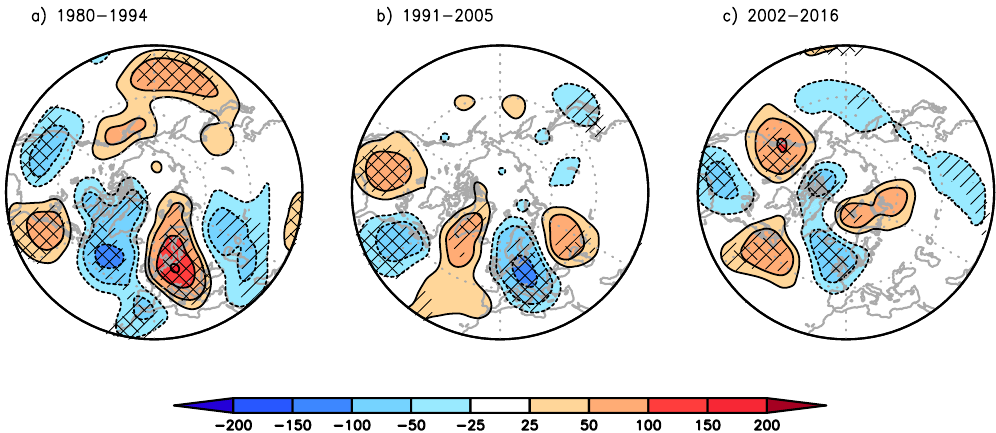
Figure 4. Secular trends (linear regression coefficient) of the geopotential disturbance at 300 hPa in [m 2 s − 2 /year] for the three stages: ( a ) 1980–1994, ( b ) 1991–2005, and ( c ) 2002–2016 for January ERA-Interim. Cross (single) hatched regions mark statistically significant trends with a 95% (90%) confidence